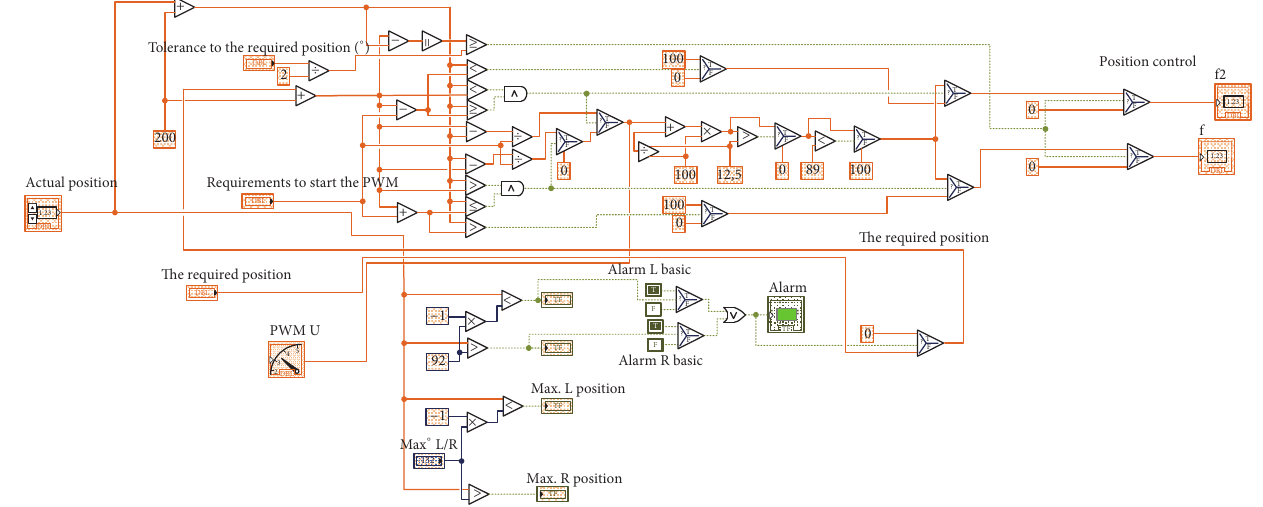
Figure 8: Block diagram of the subroutine for the position